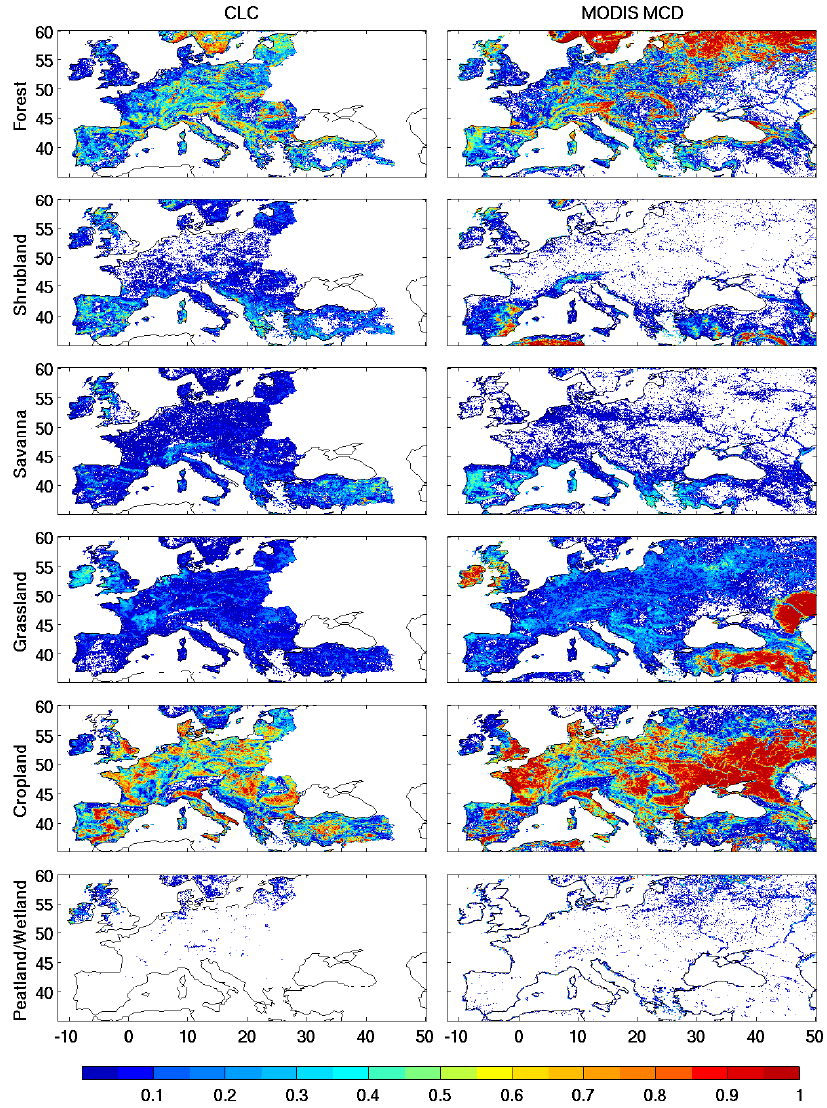
Fig. 2. Fraction of vegetation cover for grouped vegetation types and the CLC and MODIS MCD12 databases (reference year 2006), averaged on a 0 . 1 ◦ × 0 . 1 ◦ grid. For CLC, savanna corresponds to natural grassland and grassland to pasture, for MODIS MCD12, specific vegetation types are assigned to shrubland, savanna and grassland. White areas to the east of the domain in the CLC maps correspond to unavailable data.